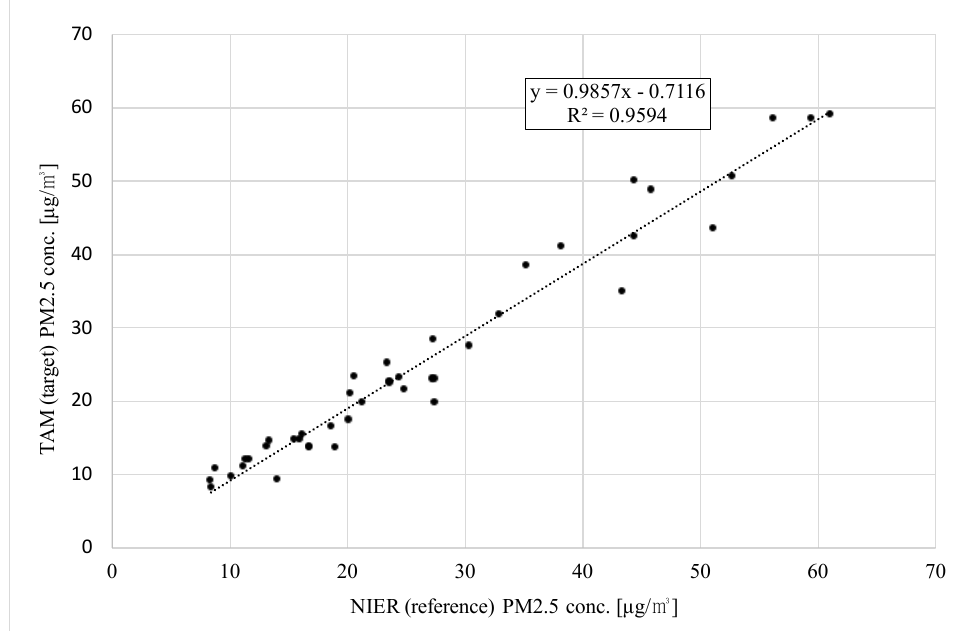
Figure 14. Correlation between TAM and NIER on daily average from 26 January to 9 March